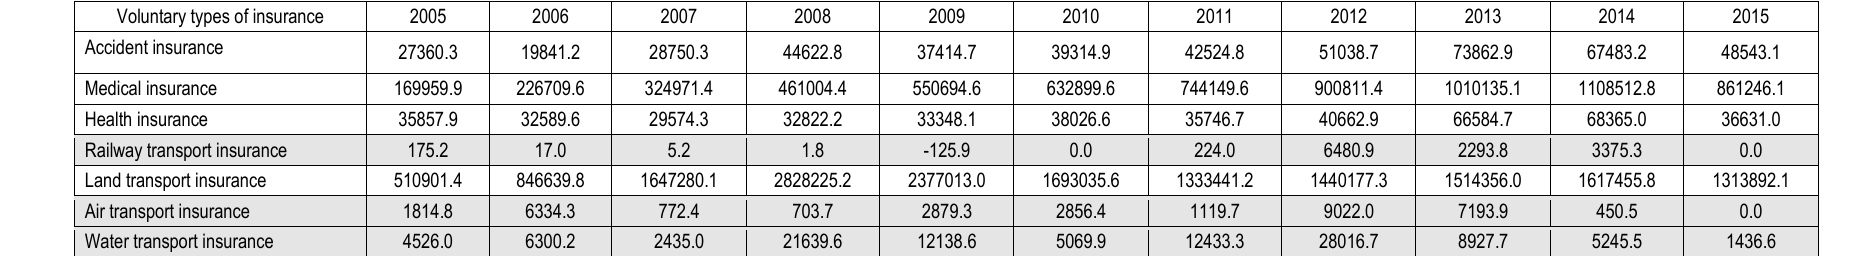
Table 2. Net insurance payments for certain types of insurance in 2005 – 2015, thousand